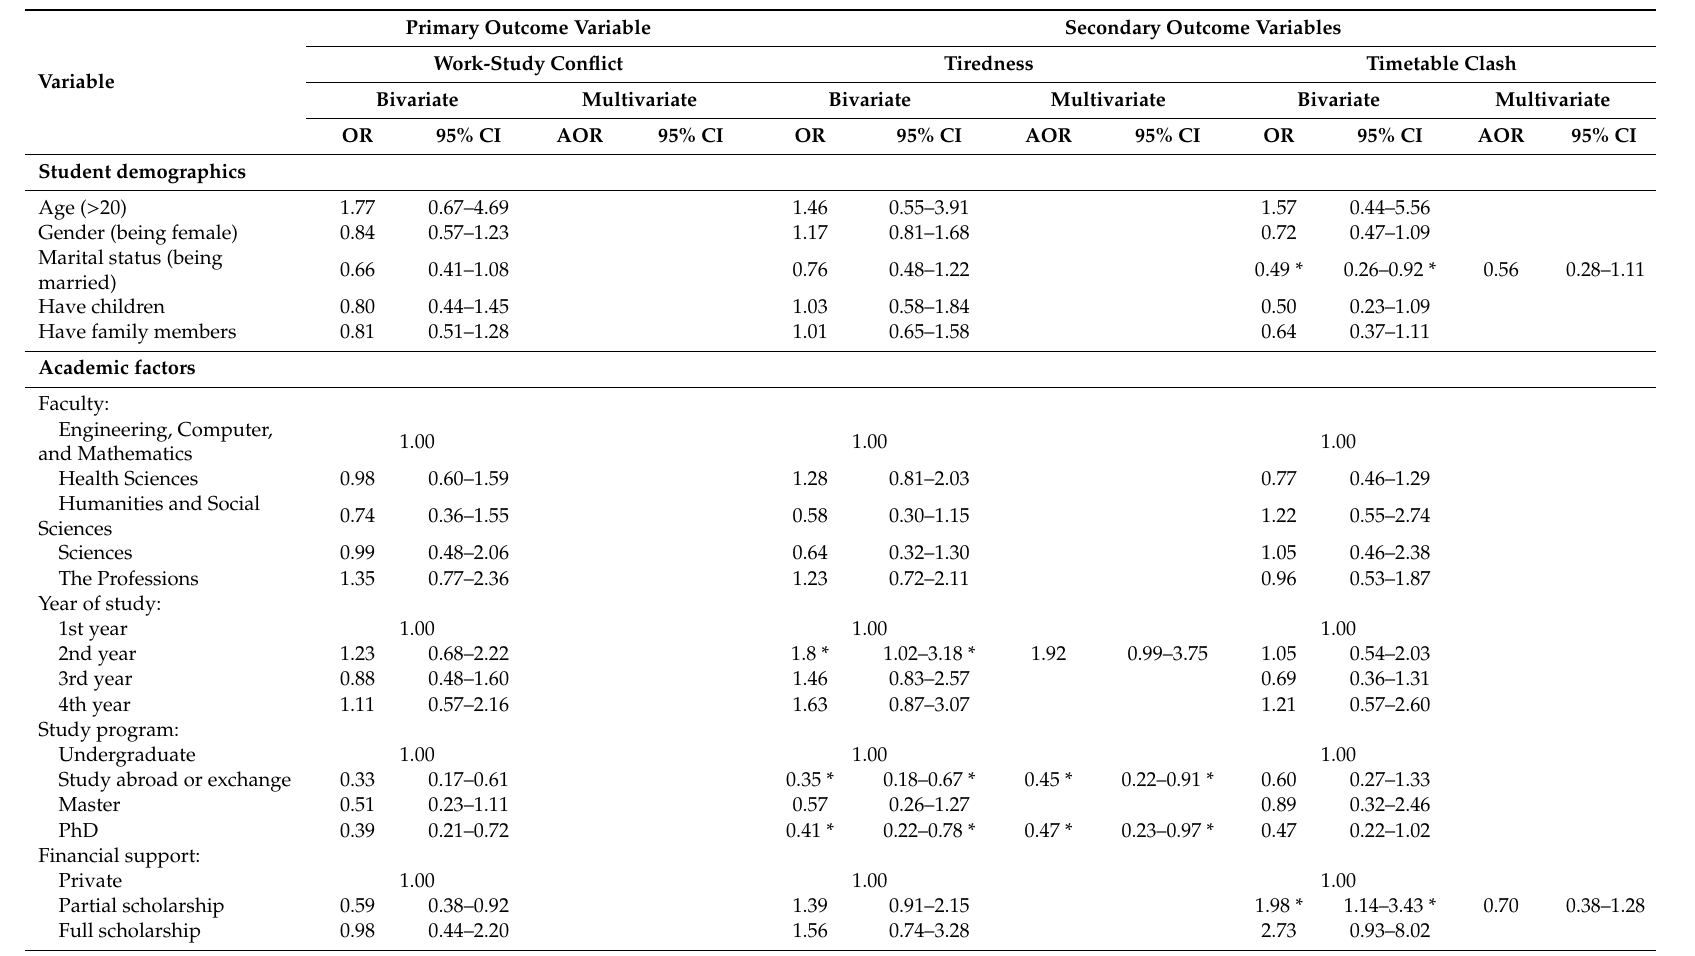
Table 2. Work-study conflict, bivariate and multivariate